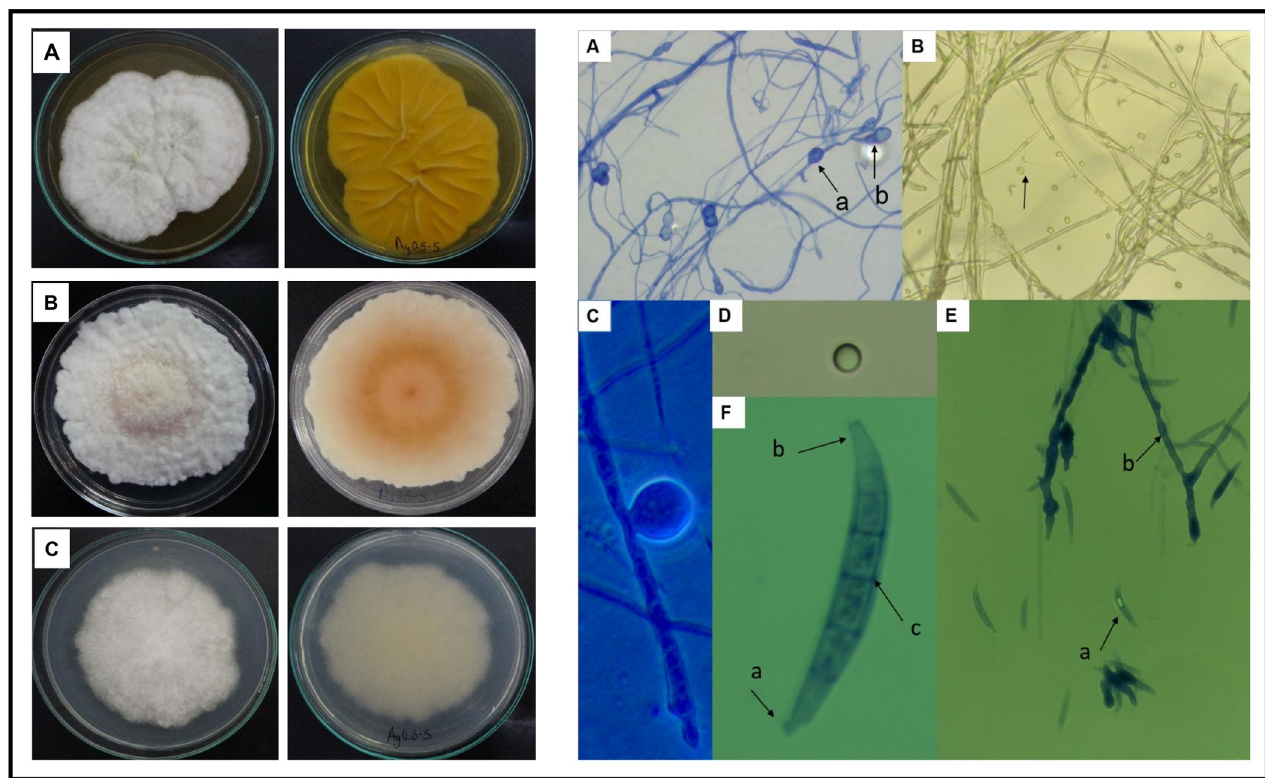
Fig 1. Colony and microscopic characteristics of the Ag0.5–5 isolate. Left panel : Colonies in different media cultures are shown: (A) Sabouraud agar, (B) PDA and (C) Czapek agar. Right panel : In vitro microcultures of the isolate were prepared and the cellular structure of fungi was observed microscopically: (A) Mycelium with intercalar (a) and terminal (b) chlamydospores in Czapek agar (Bright field, 40X with blue cotton as contrast dye). (B) Septated mycelium and microconidia in PDA agar (Bright field, 40X). (C) Intercalar chlamydospore in Czapek agar (Bright field, 100X with blue cotton as contrast dye). (D) Microconidia globosa in PDA (Bright field 100X). (E) Macroconidia (a) and chain grouped chlamydospores (b) in Czapek agar (Bright field, 40X with blue cotton as contrast dye). (F) Macroconidia in Czapek agar, septum (c), basal cell (a) and blunt apical cell (b) (bright field, 100X with blue cotton as contrast dye).